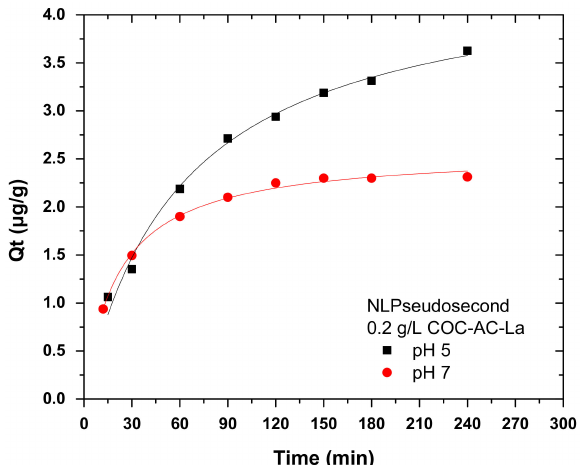
Figure 9. Kinetic pseudo-second order model for the adsorption of Cr(VI) on COC-AC-La; initial Cr(VI) concentration 100 µ g/L, solution pH 5 and 7, dose 0.2 g/L, T = 22 ± 1 ◦